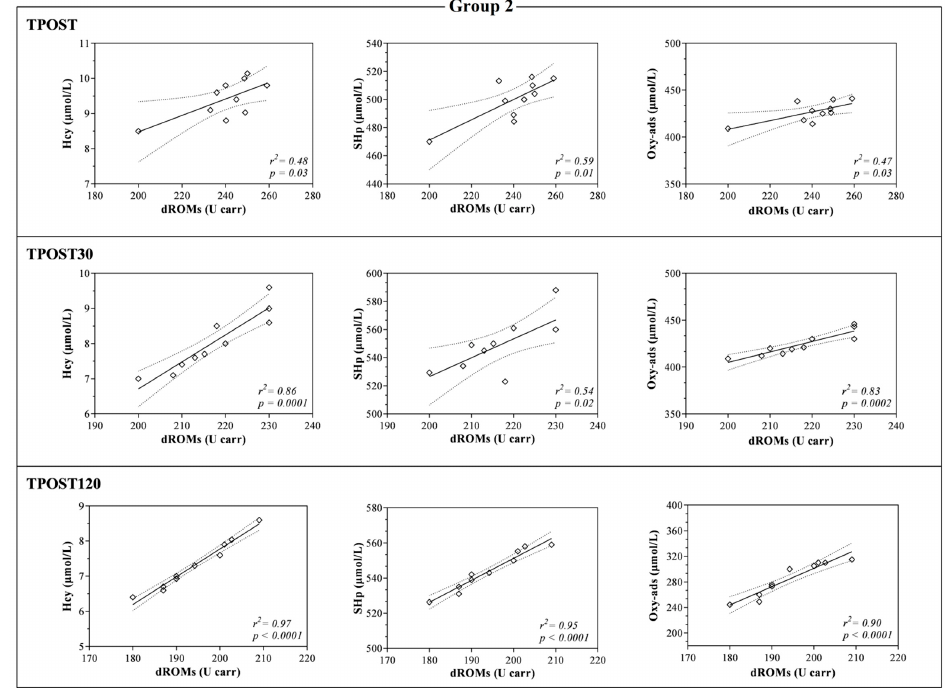
Figure 6. Linear regression values obtained between the serum concentration of reactive oxygen metabolites (dROMs) and the values of homocysteine (Hcy), thiol antioxidant barrier (SHp) and antioxidant barrier (Oxy-ads) obtained immediately after the race (TPOST), and after 30 (TPOST30) and 120 min (TPOST120) in Thoroughbred racehorses competing in 1600-m race (Group 2).